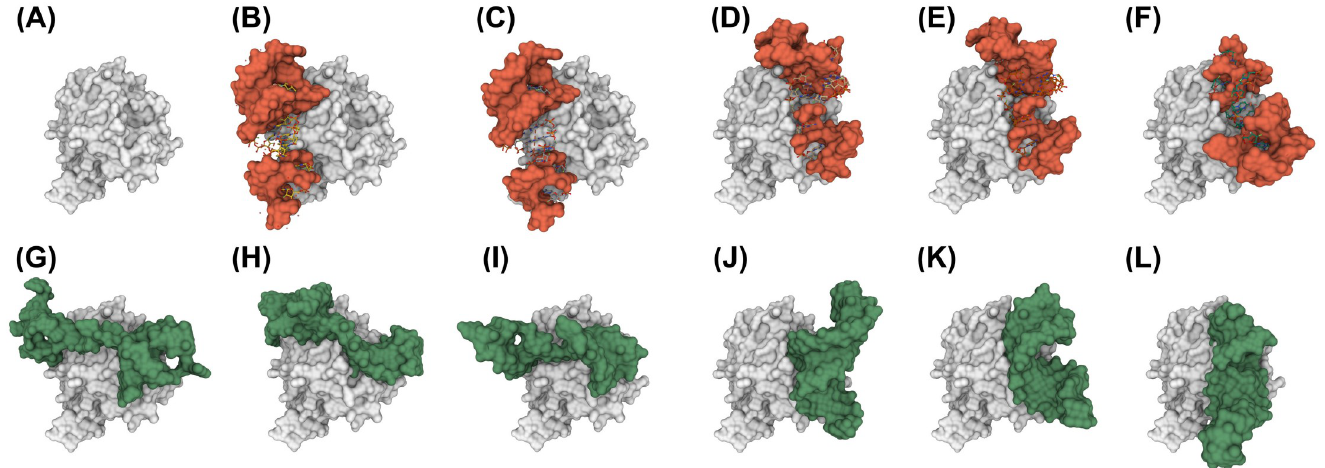
Fig 4. Comparison of binding positions between known aptamer 5VOE(chain A) depicted as a red structure in (B-F) and our candidate aptamers (green) in (G-L) for target protein 5VOE (gray) in (A-L). The structures of aptamers were predicted by SimRNA and RNAComposer and rendered using NGL viewer after the ZDOCK docking simulation was applied. (A) Target protein 5VOE and the angle is always fixed in other figures. (B) Crystallized pose of aptamer 5VOE:A. (C-F) Docked poses of aptamer 5VOE:A with RMSD 5.27 Å , 34.31 Å , 34.5 Å , and 42.33 Å respectively compared to the crytallized pose in (B). Our candidates (G-L) show similar binding positions compared to the upper binding sites of (B-F). Especially binding positions in (J-L) are quite similar to ones in (D-F).